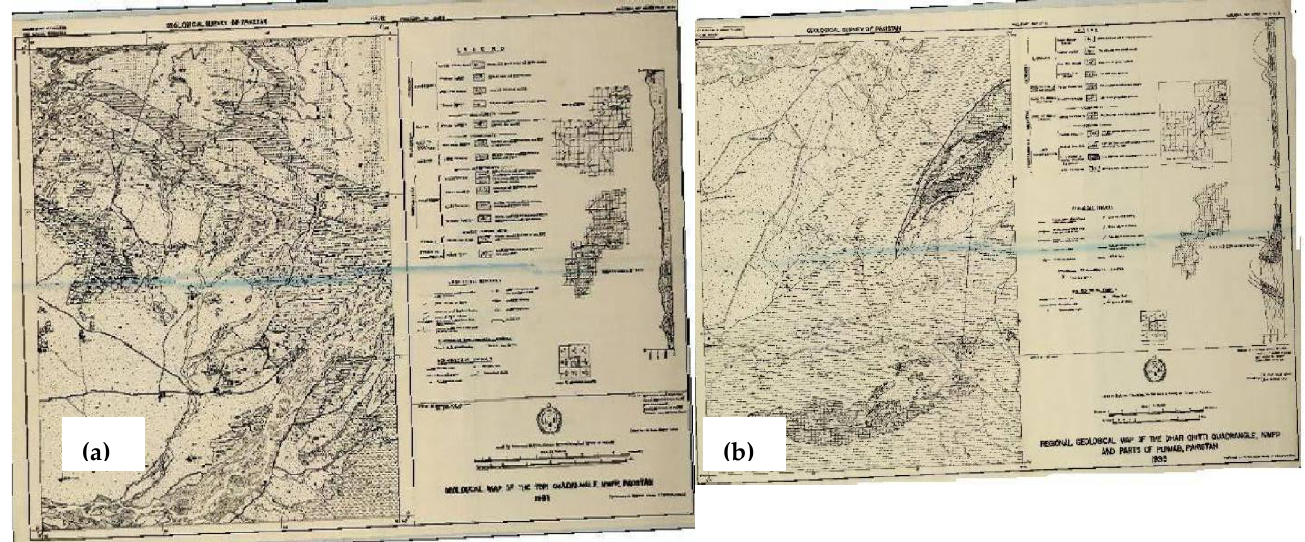
Figure 7. ( a ) Geological maps (sheet no. 43C/9) of Ghazi tehsil at a scale of 1:50,000 were used to extract the lithology information (Data Source: Geological Survey of Pakistan, Peshawar Office).